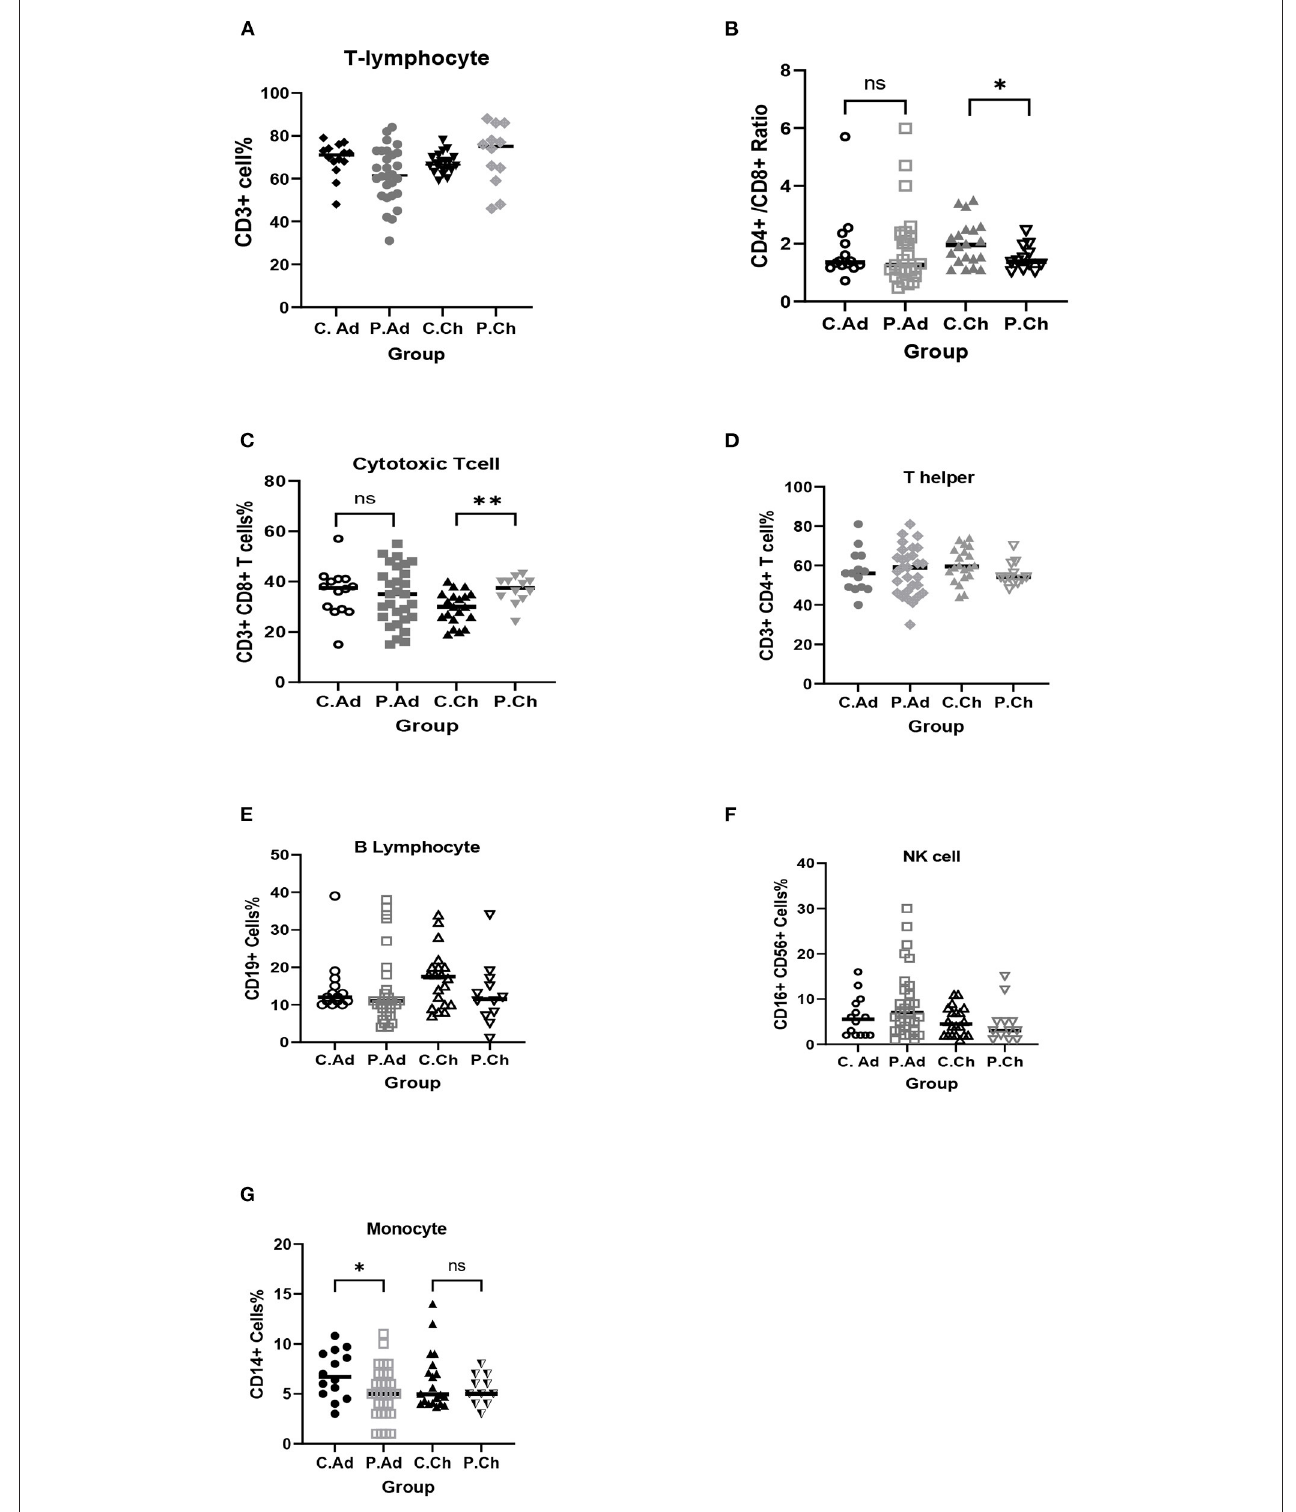
FIGURE 1 | Comparison of peripheral innate and adaptive immune cells of COVID-19 children patients (P.Ch) with matched-healthy control (C.Ch), and COVID-19 adult patients (P.Ad) with matched-healthy control (C.Ad). (A) Total T-lymphocytes (CD3 + ), (B) CD4 + /CD8 + ratio, (C) Cytotoxic T cells (CD3 + , CD8 + ), (D) T helper (CD3 + , CD4 + ), (E) B lymphocytes (CD19 + ), (F) NK cells (C16 + , CD56 + ), (G) Monocyte (CD14 + ). * p < 0.05; ** p < 0.01; NS, not significant.